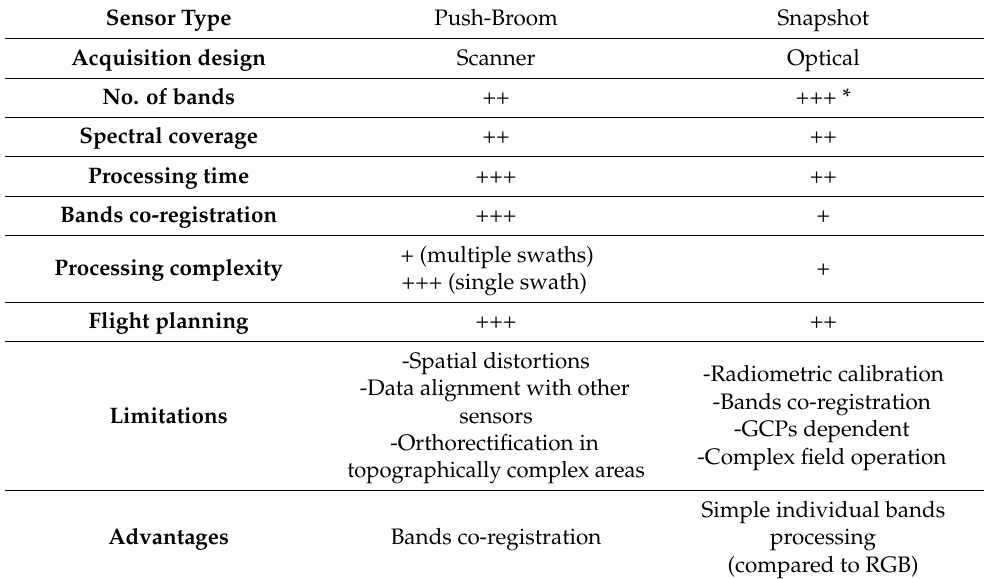
Table 8. Comparison between push-broom and snapshot approaches, regarding their advantages and limitations. For a given evaluated parameter, + indicates lower/medium performance while +++ indicates high